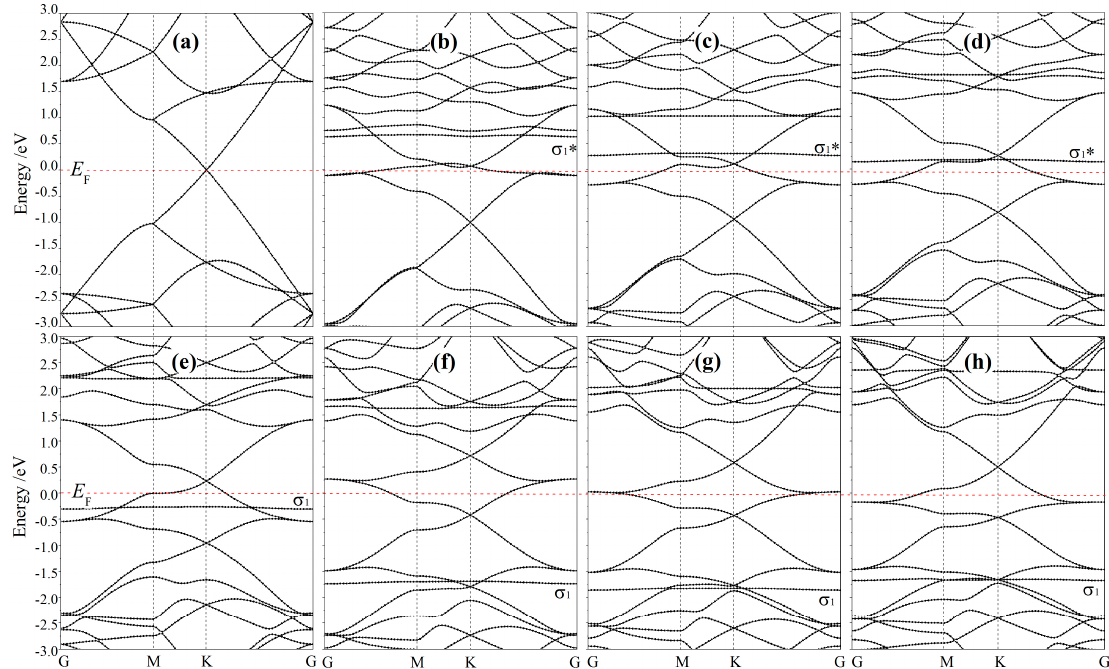
Figure 3. Electronic band structure and density of states for ( a ) pristine graphene and ( b – h ) Y, Zr, Nb, Mo, Tc, Ru, Rh/graphene C-site adsorptions, respectively. The Fermi-level is referenced as energy zero (horizontal dashed lines).